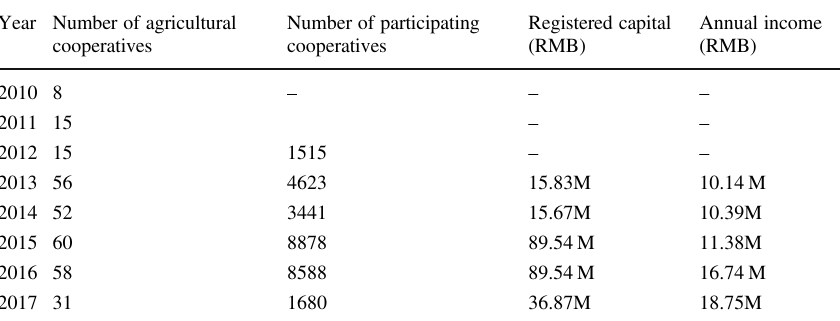
Table 2 Development of Agricultural Cooperatives in Gaize County Year Number of agricultural Number of participating cooperatives